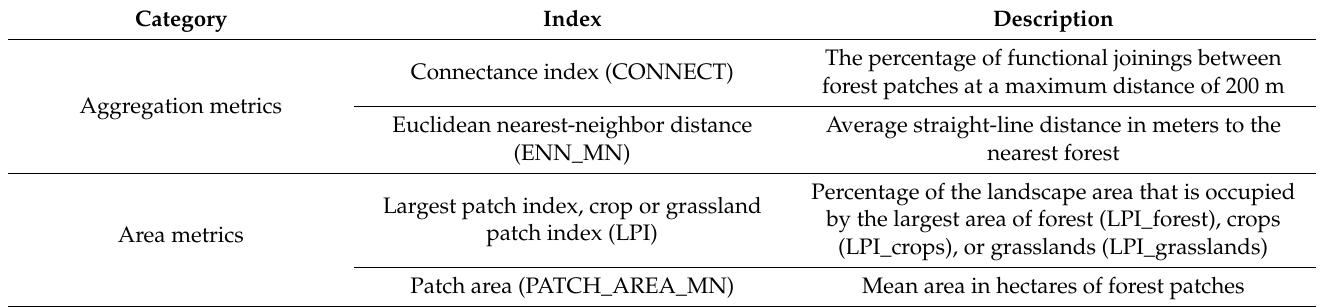
Table 1. Description of the different landscape indices used to characterize the study area. FRAGSTATS acronyms are provided in parentheses. MN = average area used. Category Index Description The percentage of functional joinings between Connectance index (CONNECT) forest patches at a maximum distance of 200 m Aggregation metrics Euclidean nearest-neighbor distance Average straight-line distance in meters to the (ENN_MN) nearest forest Percentage of the landscape area that is occupied Largest patch index, crop or grassland patch index (LPI) Area metrics (LPI_crops), or grasslands (LPI_grasslands) Patch area (PATCH_AREA_MN) Mean area in hectares of forest